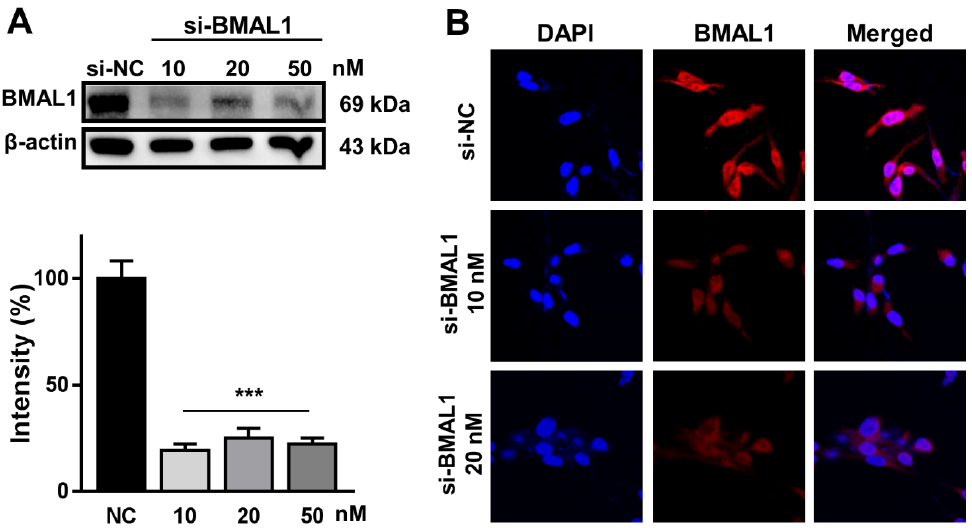
Figure 1. Brain and muscle aryl hydrocarbon receptor nuclear translocator-like 1 (BMAL1) is effectively silenced in BMAL1 small interfering RNA (siRNA)-treated U87MG cells. ( A ) U87MG cells were incubated with negative control siRNA (si-NC; 10 nM) or BMAL1 siRNA (si-BMAL1; 10, 20, and 50 nM). After 48 h, the protein level of BMAL1 was examined by Western blot with anti-BMAL1 antibodies, normalized with β -actin, and calculated as a percentage of the si-NC. Data are expressed as the mean ± standard error of the mean (SEM) (one-way ANOVA test, *** p < 0.001 vs. si-NC, three independent experiments). ( B ) Immunofluorescence of BMAL1 expression in U87MG cells transfected with si-NC (10 nM) or si-BMAL1 (10 and 20 nM).